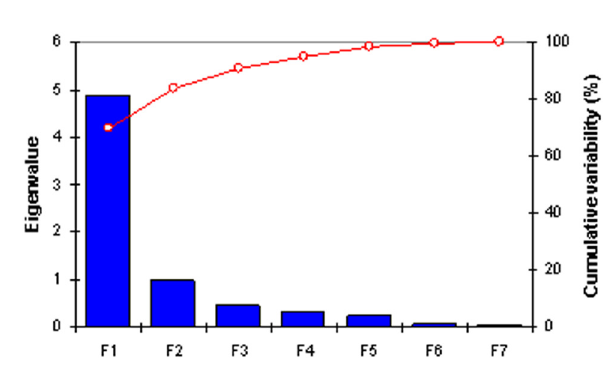
Figure 1. Factors and cumulative variability (%). Table 5. Estimated daily intake of metal (DIM) from